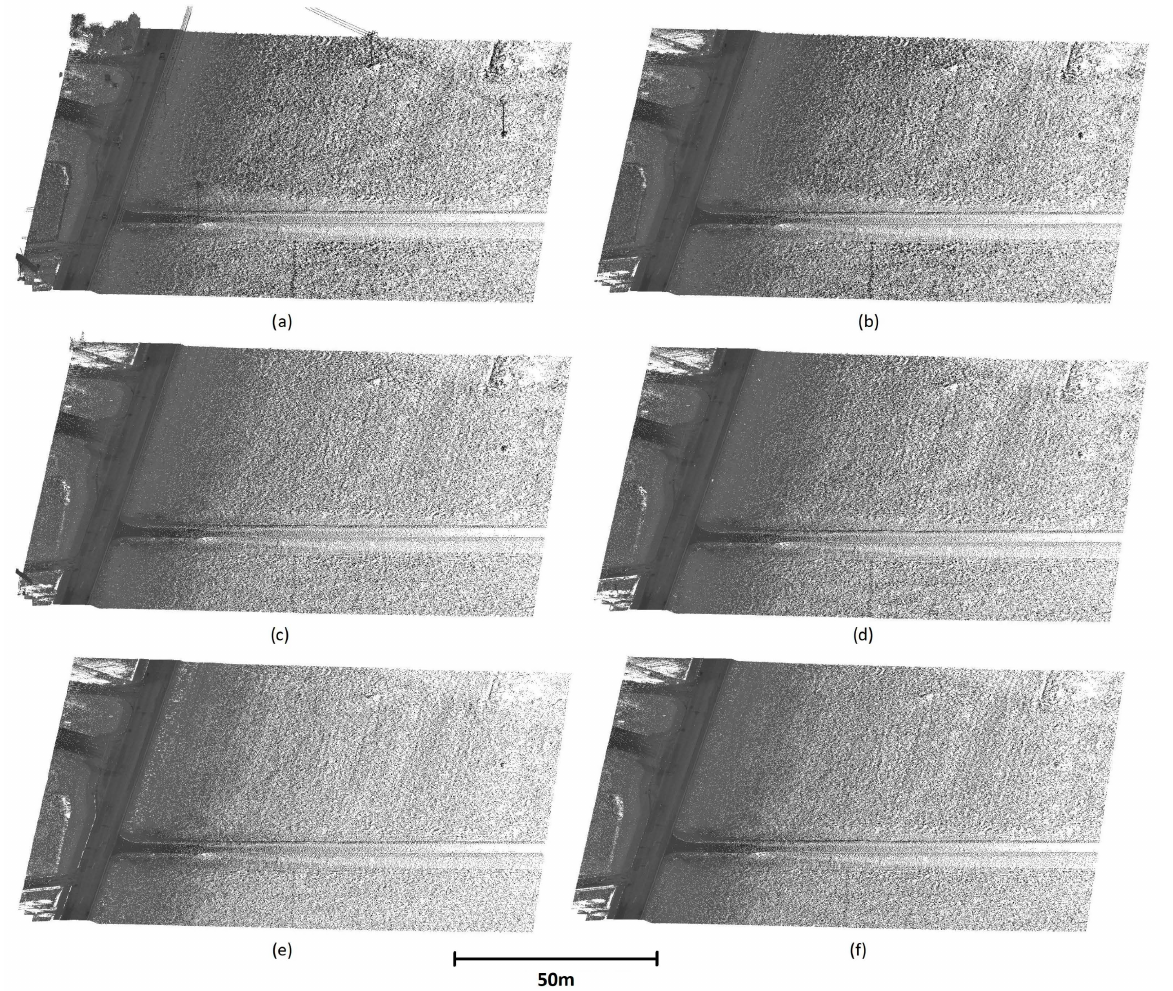
Figure A2. Results of filtering of site 1: ( a ) original data, ( b ) after PMF filtering, ( c ) after SMRF filtering, ( d ) after CSF filtering, ( e ) after ATIN filtering, and ( f ) after MDSR